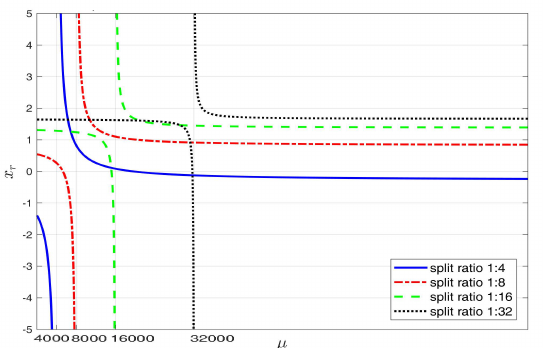
Figure 2. Contour plots of f ( x r , µ ) = 0 against different values of split-ratio N ∈ { 4,8,16 } and D QoS = 1